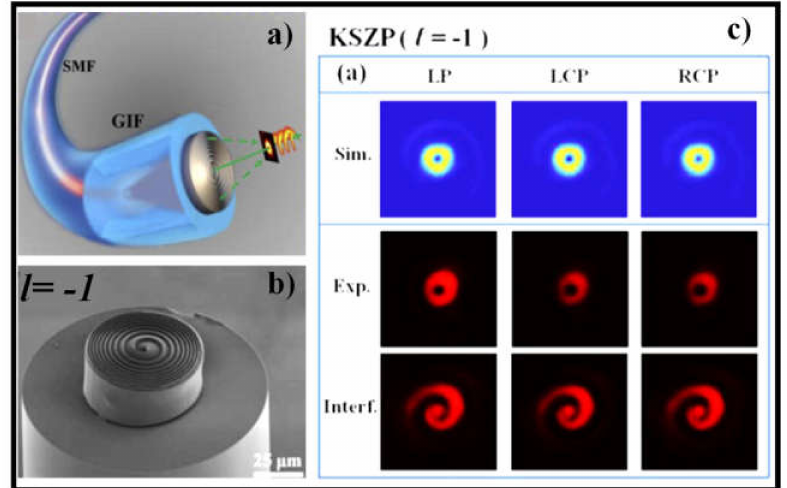
Figure 6. ( a ) Graphical design of all-fiber focused OV beam generator [141], ( b ) SEM image of the nanoimprinted KSZP microstructure with topological charge l = − 1 [141], and ( c ) focal spot profiles acquired from FDTD simulation (top row), experimental measurement (middle row), and the measured coaxial interference forms (bottom row)